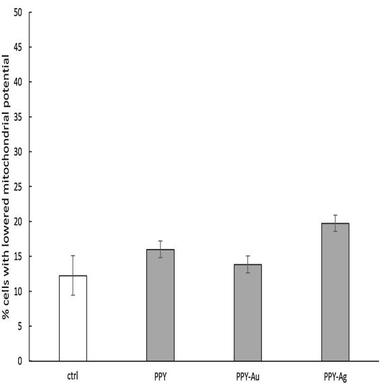
The cytotoxicity of filtering paper covered with polypyrrole, polypyrrole–Au composite and polypyrrole–Ag composite in the culture of THP-1 monocyte cells line.